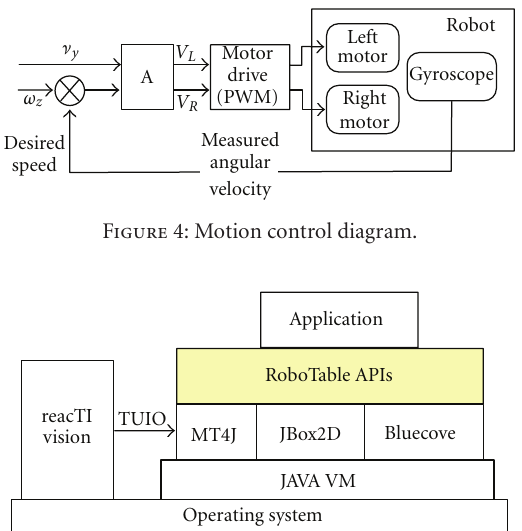
Figure 3: Robot connection flow chart.